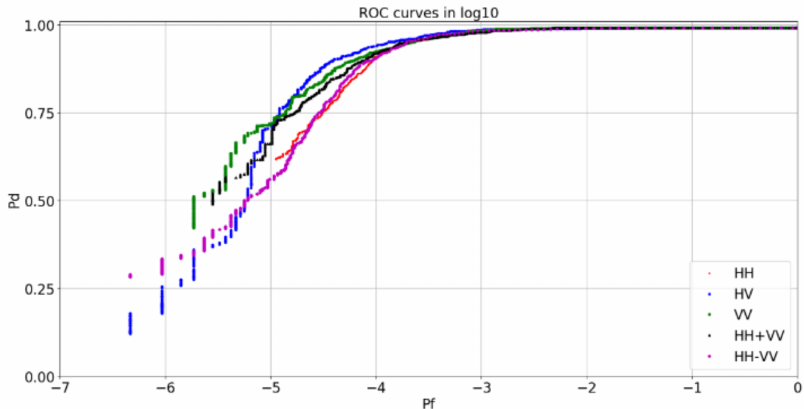
Figure 20. Iceberg detection intensity ROC curves for sea ice, 5 × 5, clutter window 105 × 105. C11 is a HH polarisation, C22 is a cross-polarised HV polarisation, C33 is a VV polarisation, T11 is a HH + VV polarisation and T22 is a HH − VV